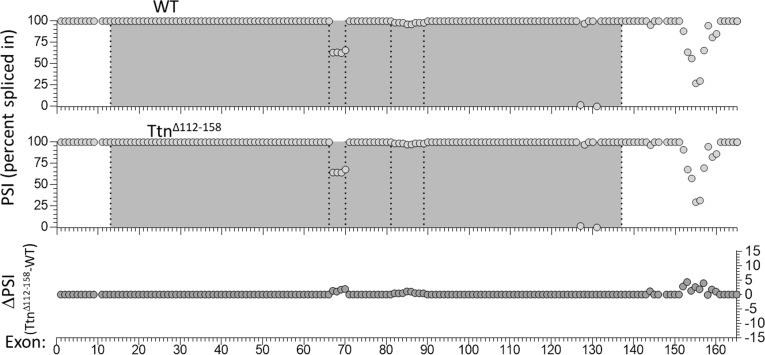
Nebulin exon expression analysis in diaphragm muscle.RNAseq-based nebulin exon expression of diaphragm muscle, expressed as percent spliced in (PSI) in WT (top) and Ttn∆112-158 mice (middle), and the PSI difference between the two genotypes (bottom). Several exons in the middle of the gene (exons 66–70 and exons 82–89) are slightly upregulated (<5%) in the Ttn∆112-158 diaphragm but differences are not significant. In these regions a super-repeat duplication and a super-repeat triplication are found (making for 25 super-repeats in the mouse Neb gene). Several exons towards the C-terminus (Z-disk region) are also slightly upregulated, but differences are not significant.